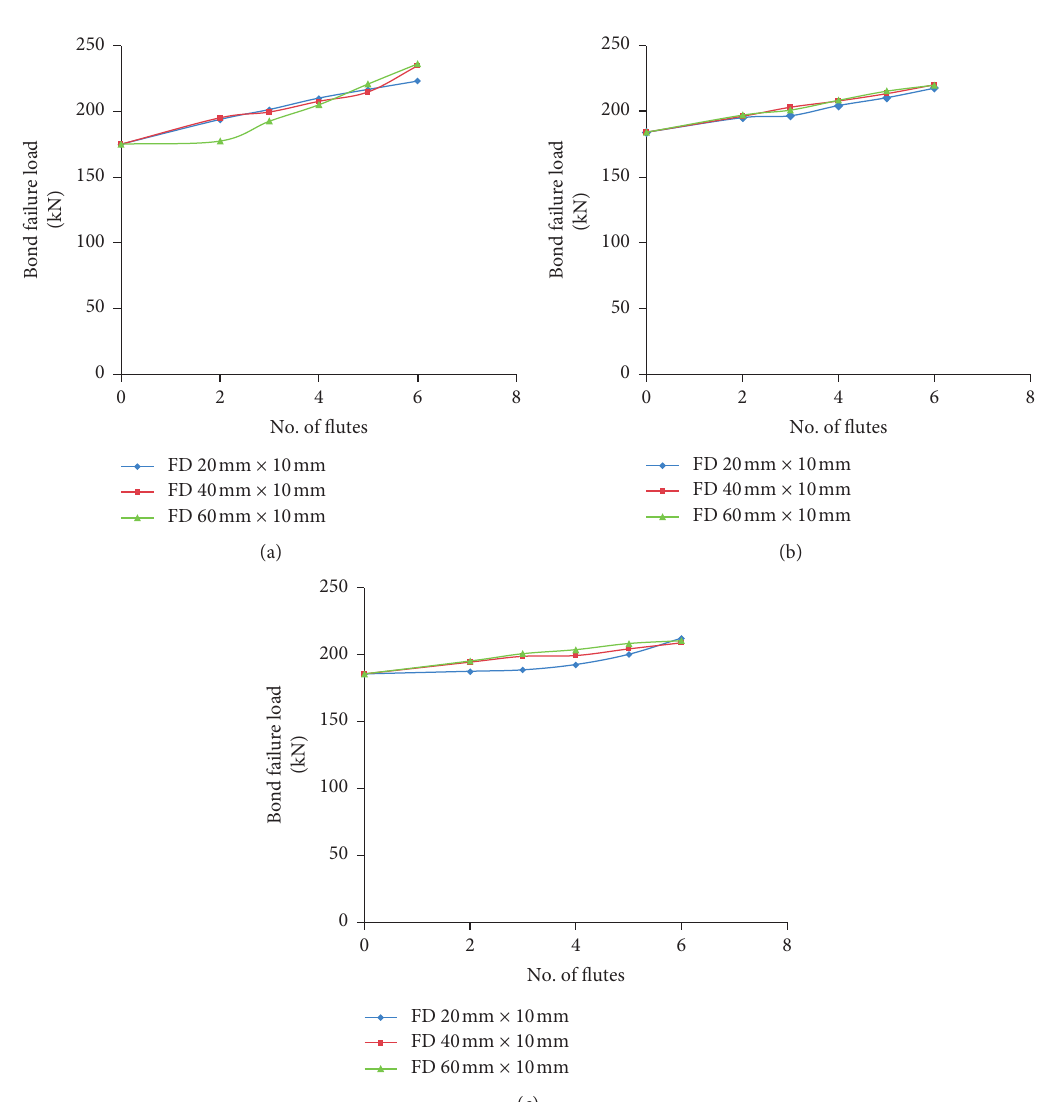
Figure 9: Bond failure load vs number of flutes: (a) D / t � 40; (b) D / t � 60; (c) D / t � 80.